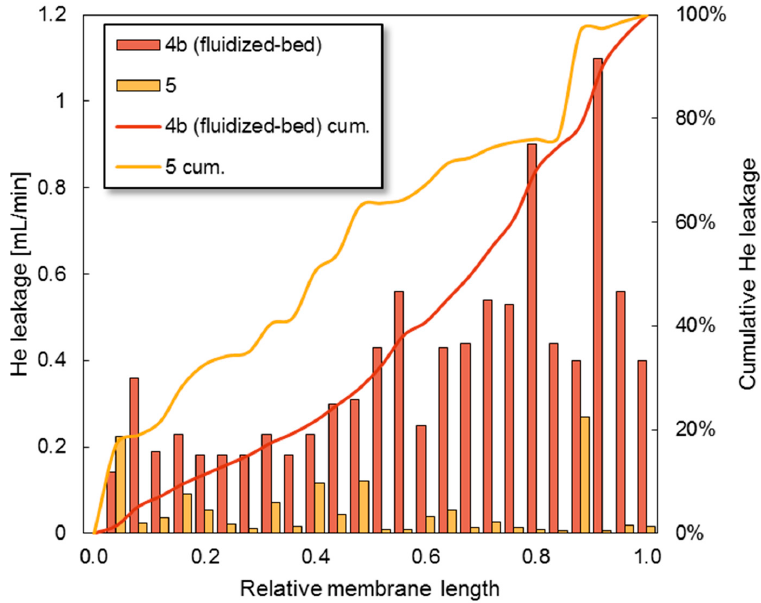
Figure 11. Helium flow rate distribution along the membrane 4b and 5.